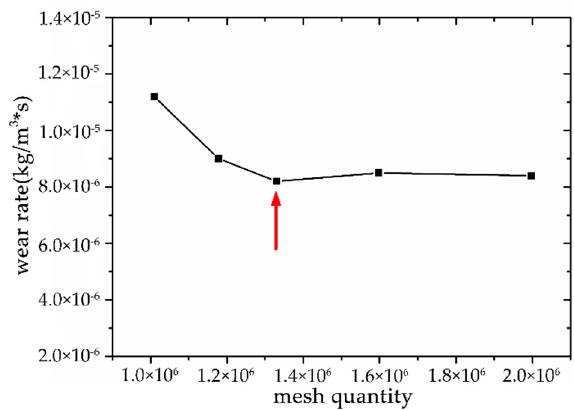
Figure 7. Mesh independence test.